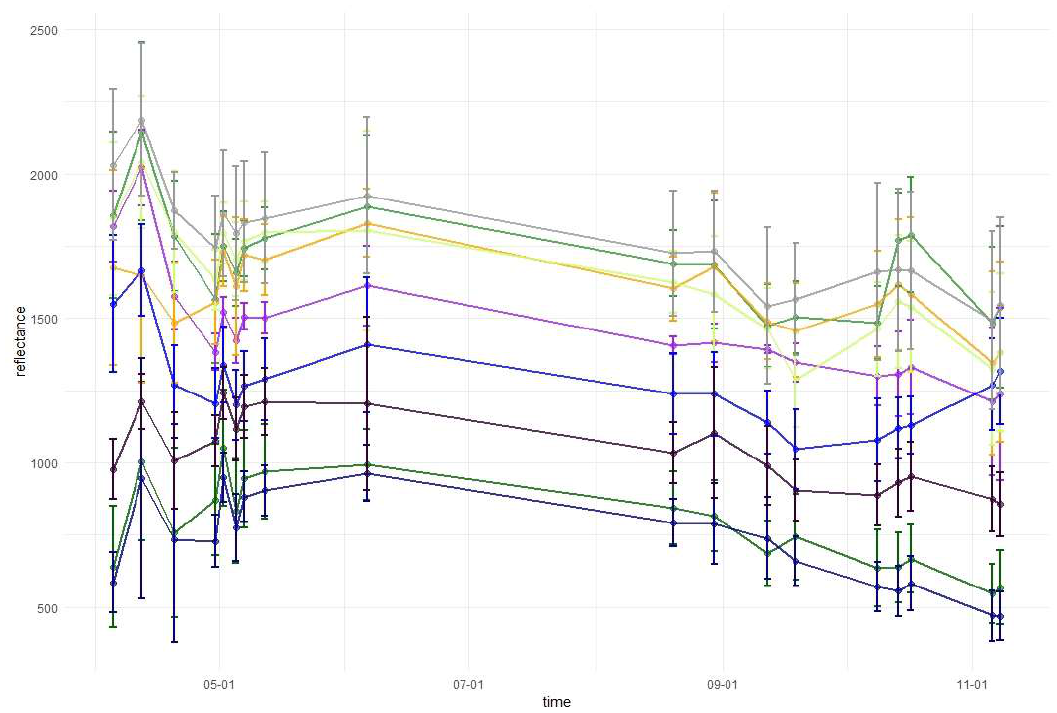
Figure A9. Mean and standard deviation values of reflectance in the short-waved 1 infrared band.